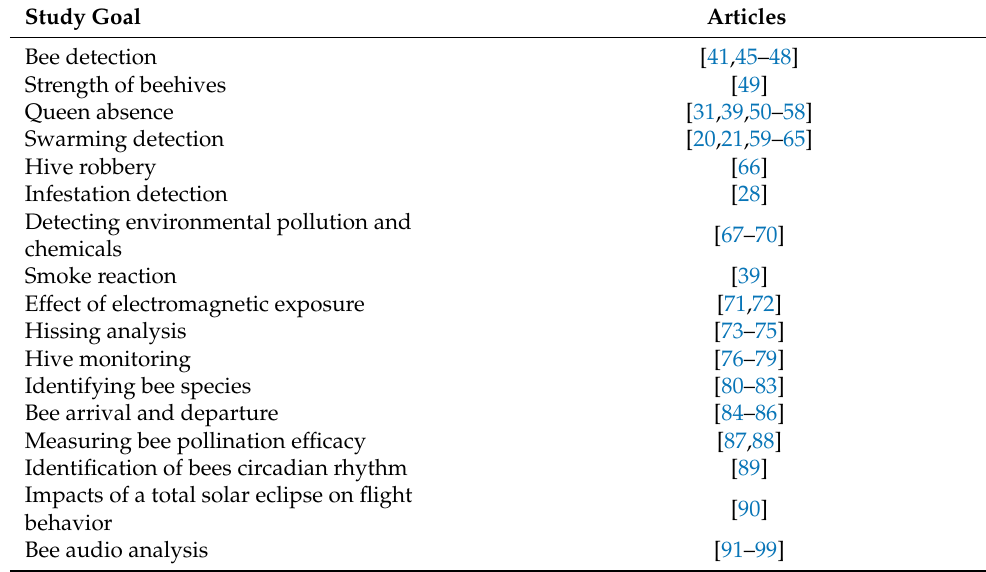
Table 3. List of articles exploring different study